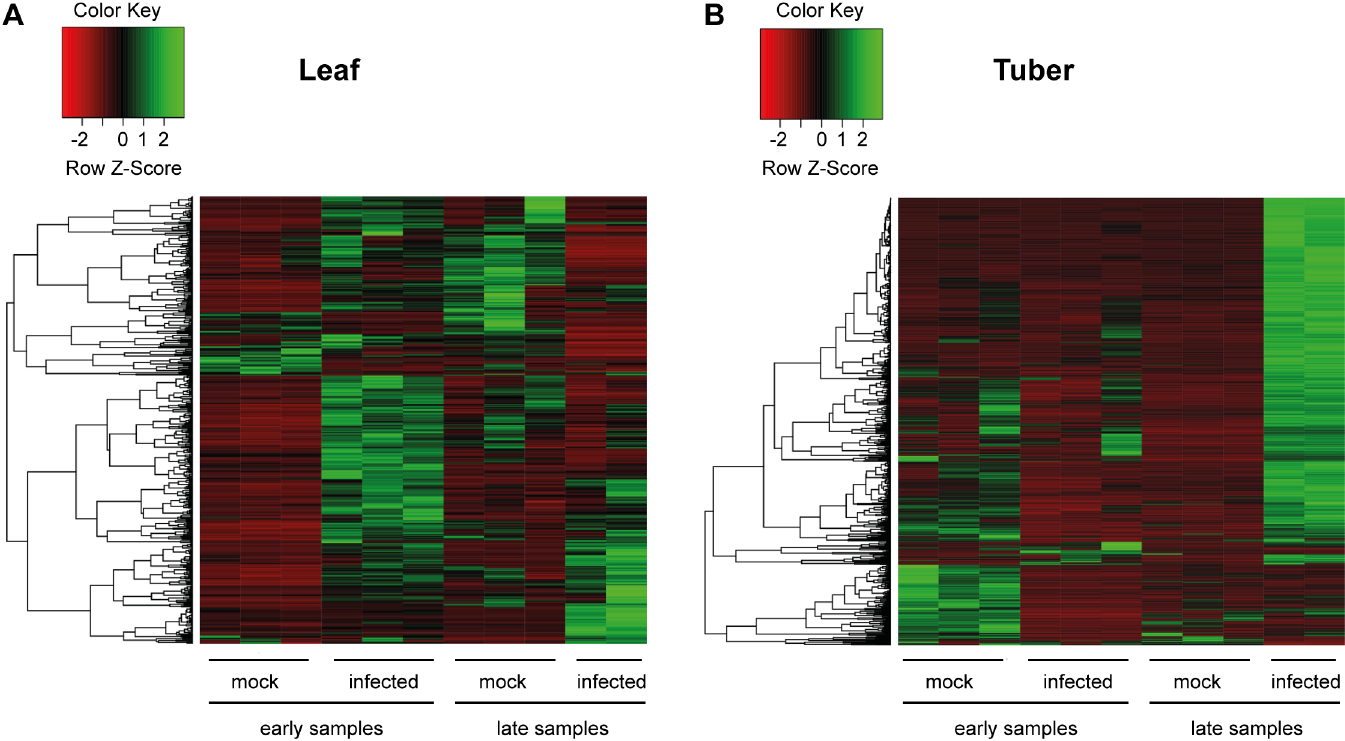
Fig 2. Heatmap representation of differentially expressed genes upon PSTVd infection. Visualization of differentially expressed genes of leaf (A) and tuber (B) tissues in mock inoculated and infected plants as indicated. Three biological replicates are shown, but for late infected tissues only two. Colour key indicates the expression change compared to mock inoculated